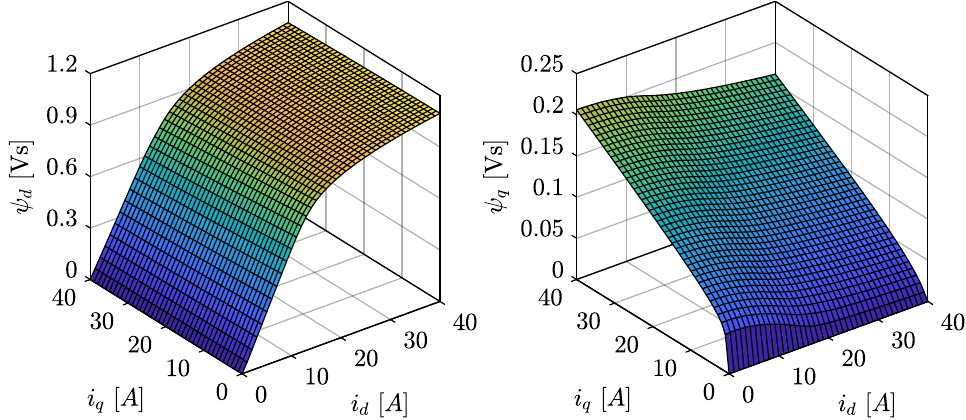
Figure 5. Flux maps d -axis flux linkage ( left ) and q -axis flux linkage ( right